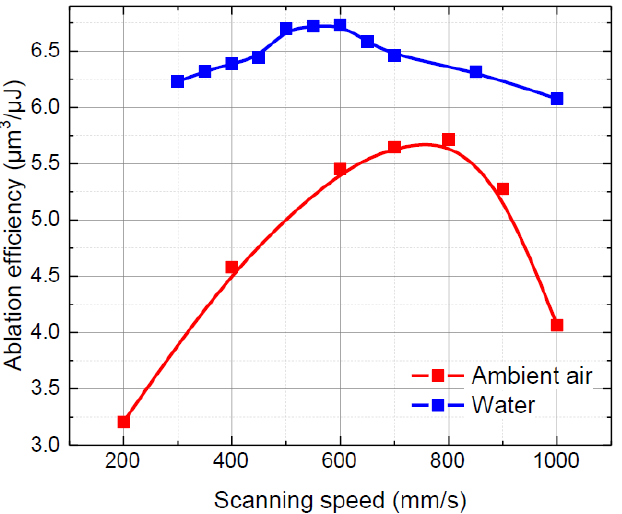
Figure 5. Ablation efficiency versus the laser beam scanning speed in ambient air and water. Dots are connected to guide the eye.